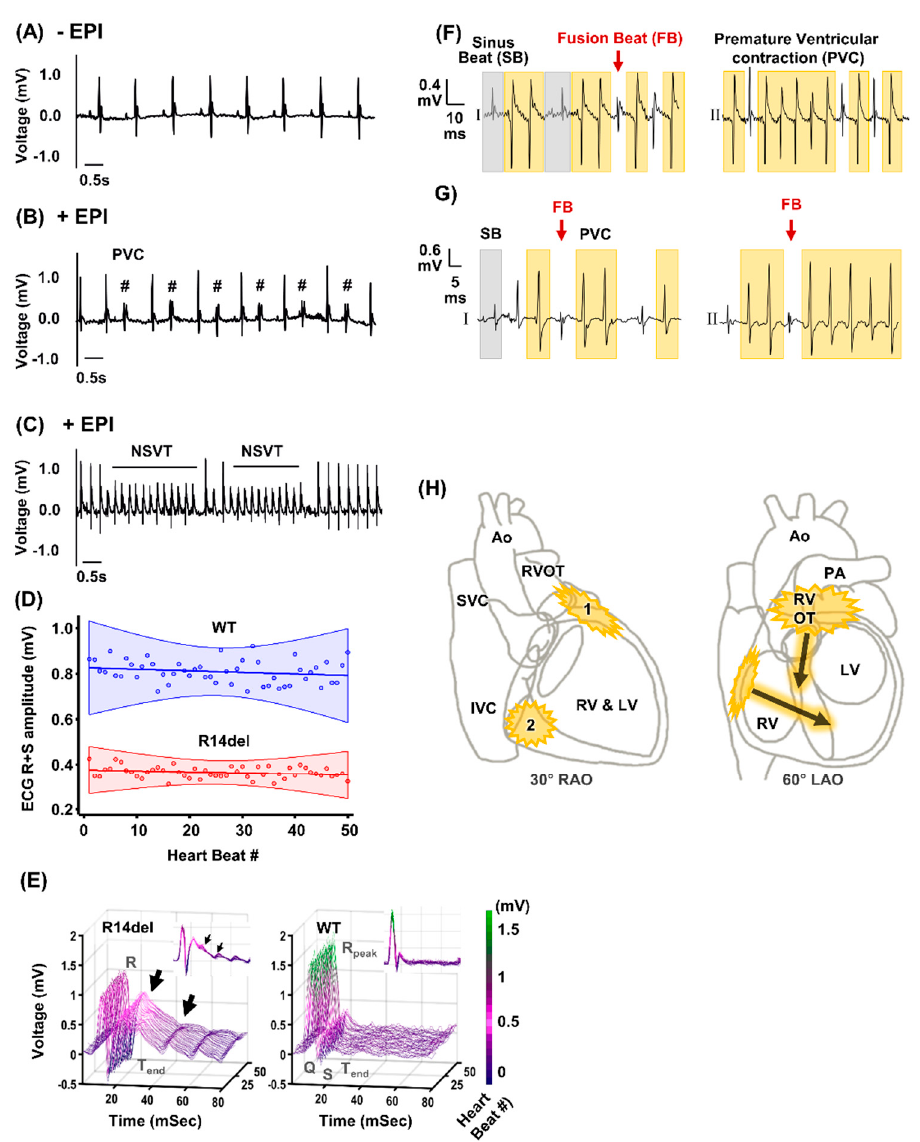
Figure 2. In vivo electrophysiological characteristics and putative source of the ventricular arrhythmias in R14del-PLN mutant mice. ( A ) ECG tracing under basal condition in R14del-PLN mice. ( B , C ) ECG tracings showing stress (caffeine and epinephrine) induced arrhythmias in the forms of premature ventricular complexes (PVCs, #), and non-sustained ventricular tachycardia (NSVT) in R14del-PLN mice (N = 5). ( D ) The mean R+S wave amplitudes with linear regression fit (solid line) and 95% confidence intervals (shaded) are shown for 50 consecutive heartbeats at a steady state for WT and R14del mice. ( E ) Representative ECG traces are plotted for 50 consecutive heartbeats at a steady state as a function of time and heartbeat number. The R14del mice (left panel) had reduced R wave amplitudes, prolonged QT and increased dispersion of repolarization (arrows) compared to wild type (WT). ( F ) Representative ECG tracings of PVC and VT beats from R14del-PLN animals are shown from leads I and II. The presence of fusion beats (red arrow) is diagnostic of PVC and non-sustained VT. Compared to the sinus beats (grey shaded areas), the morphology of the PVC and VT beats (yellow) suggests that these beats originated from or near the right ventricular outflow tract (RVOT). ( G ) Representative example of another common morphology of the PVC and VT beats from leads I and II for another R14del-PLN animal. The net QRS vector suggests these PVC and VT beats originated from the basolateral free wall of RV. ( H ) The two most common origin sites for PVC and VT in R14del-PLN mice are summarized in the 30 ◦ right anterior oblique (RAO) and 60 ◦ left anterior oblique (LAO) schematics of the heart (Ao = aorta; SVC = superior vena cava; IVC = inferior vena cava; PA = pulmonary artery; LV = left ventricle).